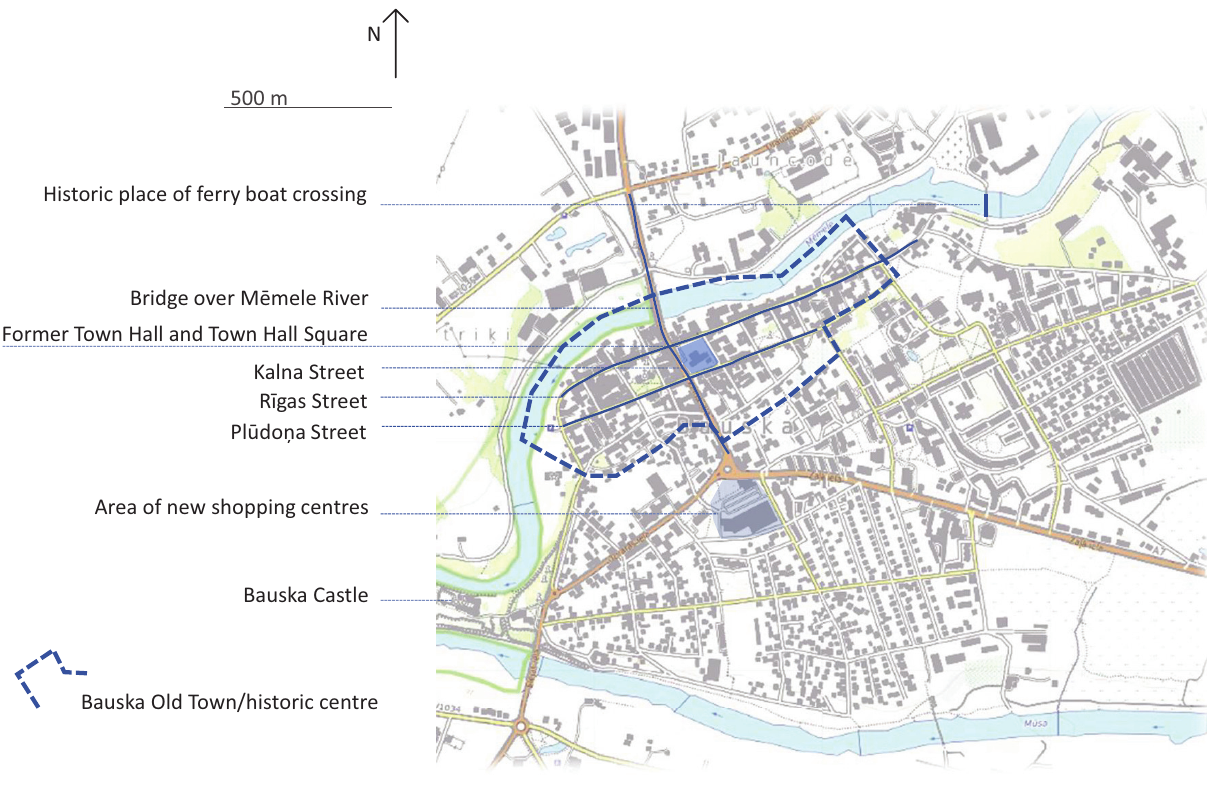
Figure 1. Spatial structure of